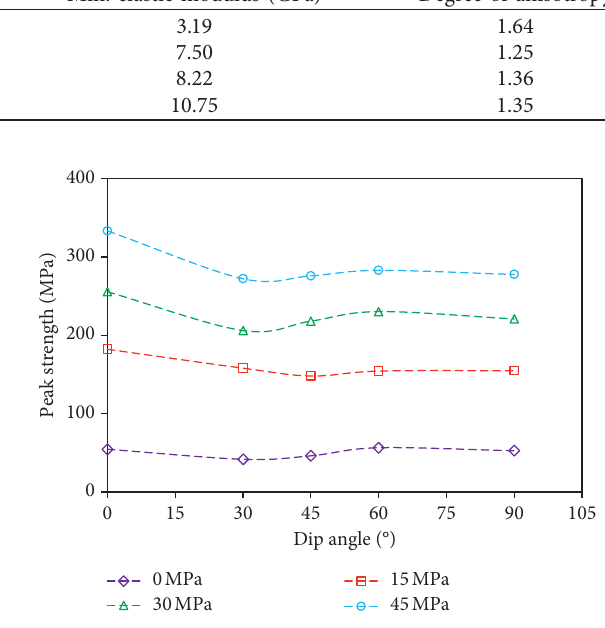
Figure 7: Triaxial compression strength anisotropy of samples with different strata